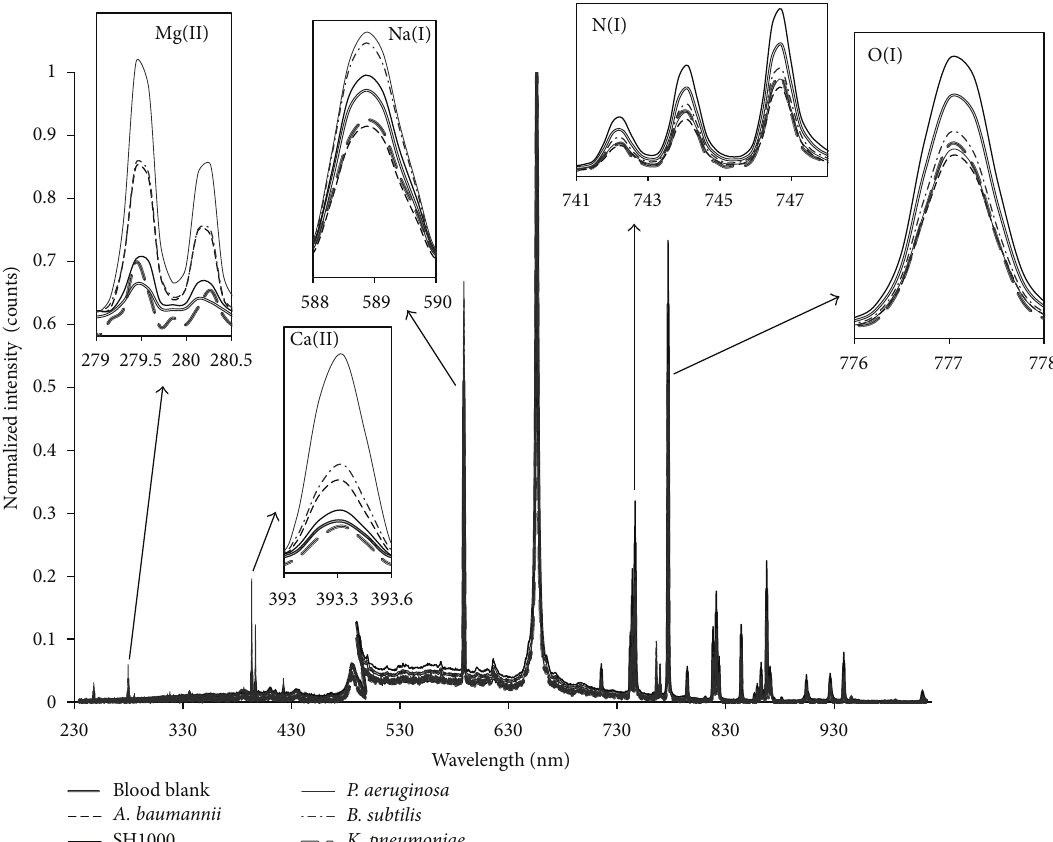
Figure 2: Examples of LIBS classification spectra used for building models for species and blank blood agar